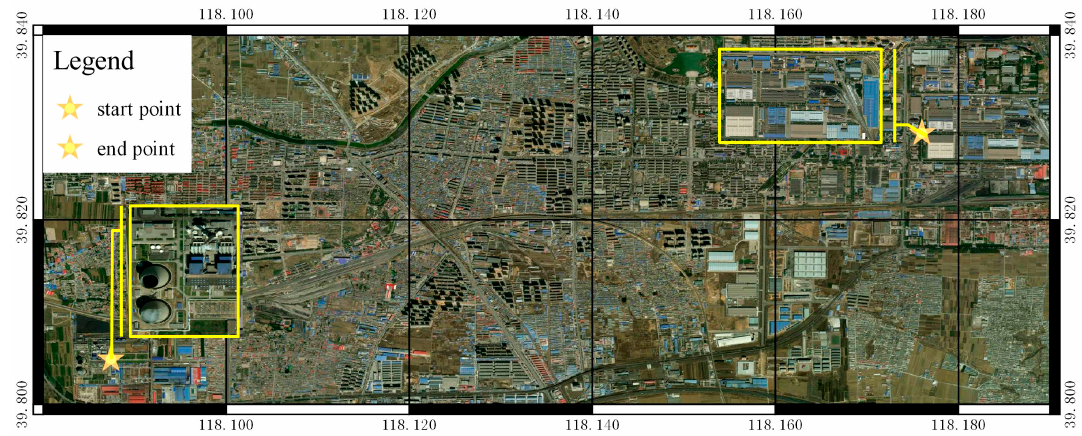
Figure 1. The location of the heating engineering project.